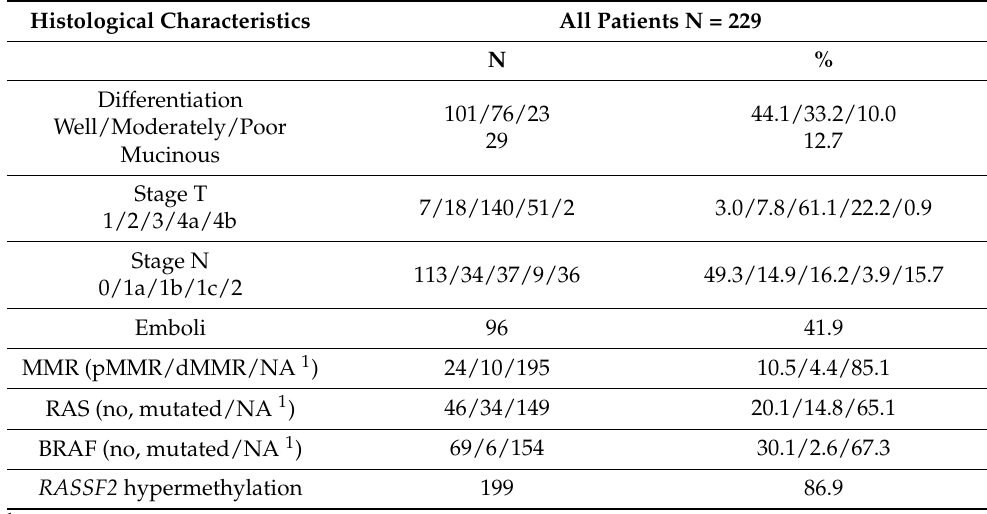
Table 2. Histological characteristics of the cohort. Histological